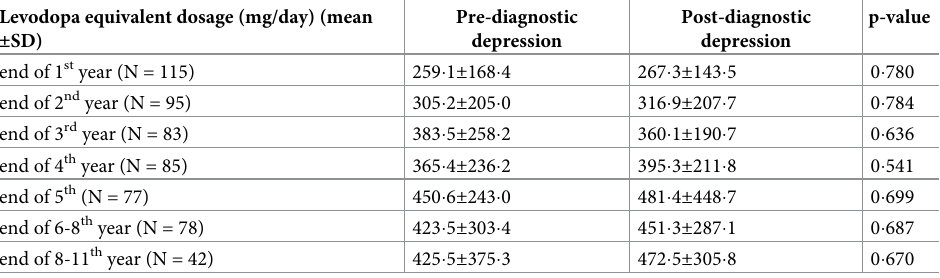
Table 4. Levodopa equivalent dosage in PD patients with and without premotor